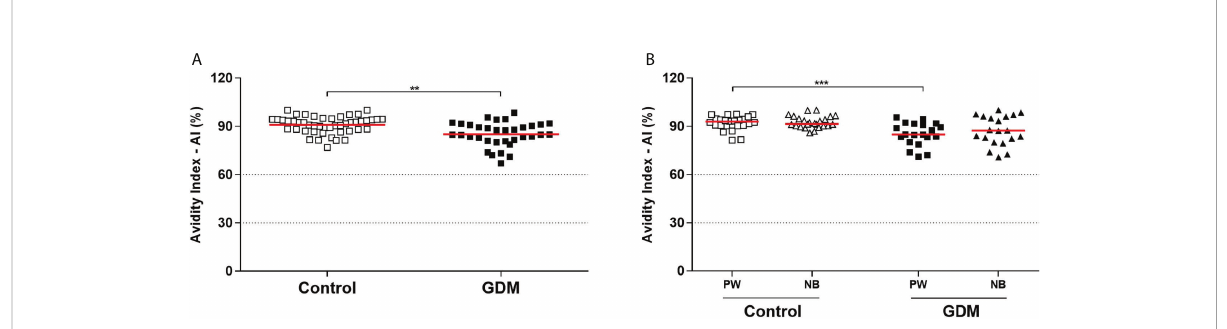
FIGURE 3 Anti- T. gondii total IgG antibodies avidity index, expressed as a percentage (%). (A) Samples from 81 pregnant women (34 GDM and 47 controls). (B) Samples from 45 pregnant women (20 GDM and 25 controls) and their respective newborns. Dotted lines demarcate areas that represent low avidity (0 – 30%), indeterminate avidity (30 – 60%), and high avidity (> 60%). The red line represents the median of the values. Statistically signi fi cant data, p < 0.05 **Unpaired t -test ***Mann-Whitney U test. PW, Pregnant women; NB, Newborn; GDM, Gestational diabetes